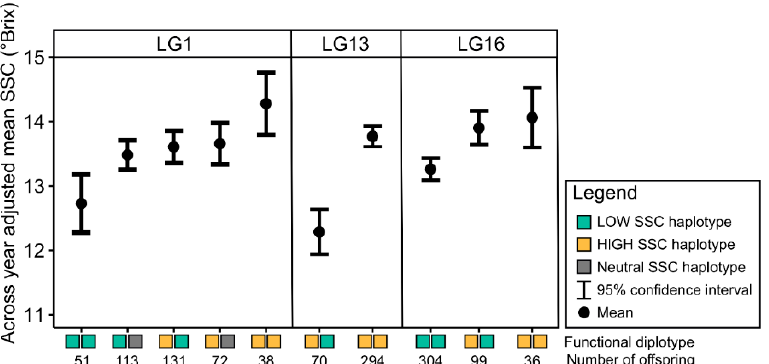
Figure 2. Means and 95% confidence intervals for across ‐ year adjusted soluble solids content (SSC) for offspring functional diplotypes at the LG1, LG13, and LG16 QTLs. Low ‐ SSC haplotypes were 1D, 1E, 13J, 16A, 16B, 16C, and 16D (corresponding to designations in Table 3). High ‐ SSC haplotypes were 1A, 1F, 13A, 13B, 13C, 13D, 13E, 13F, 13G, 13H, 13I, 16E, 16F, and 16H (corresponding